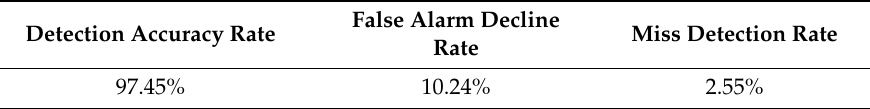
Table 3. The performance indexes of the suppression algorithm.